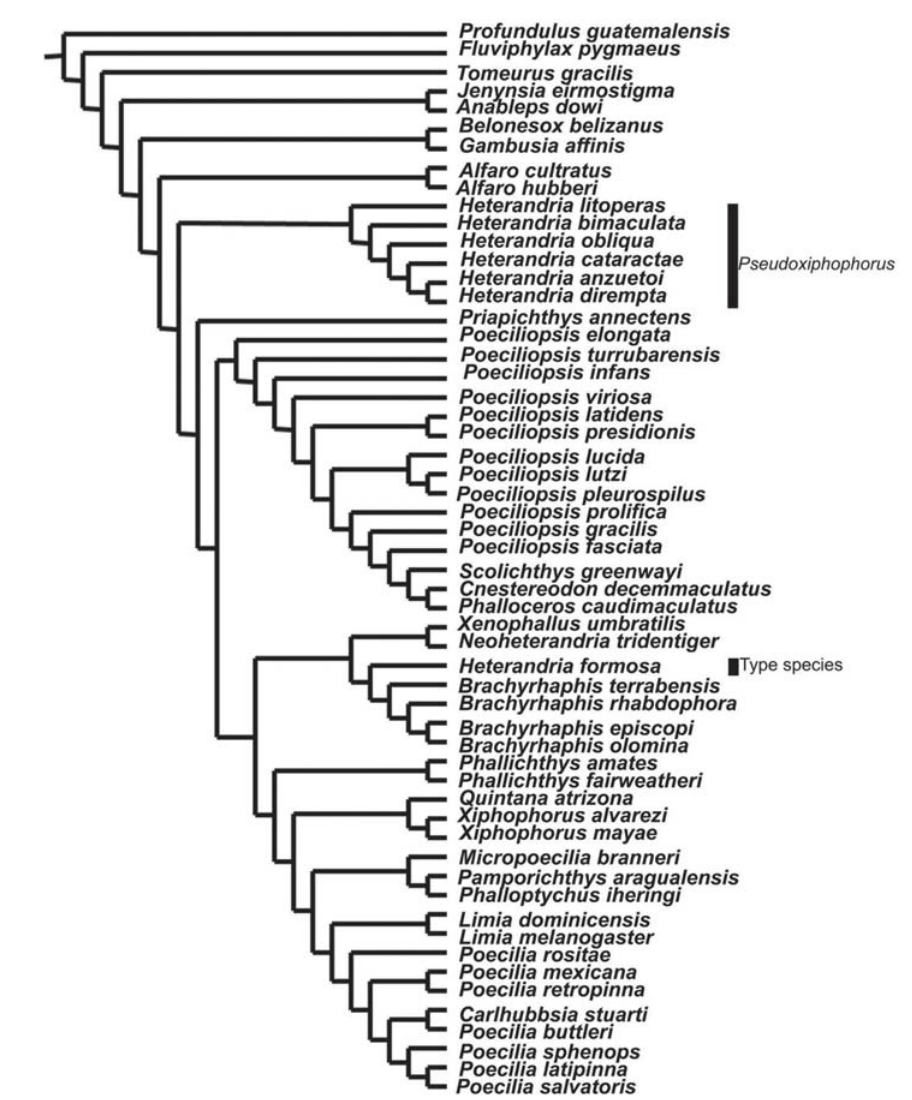
Fig. 3. Single MP cladogram with multistate characters analyzed as ordered, and a posteriori weighting on the RC (1,446 steps, CI = 0.20, RI = 0.47, RC =